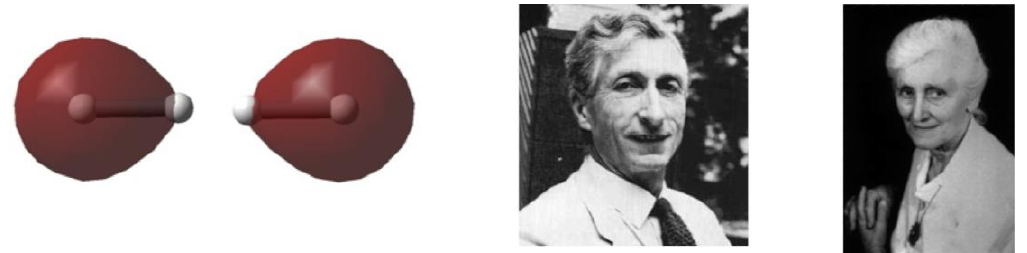
Figure 3. The two Coulson–Fischer AOs, for the H 2 molecule (using STO-3G for simplicity). On the right are photos of Coulson and Fischer. Coulson’s photo was taken from https://iaqms.org/deceased/coulson.php (accessed on 11 March 2021). Fischer’s photo was taken from http://www.quantum-chemistry-history.com/Fi_Hjal1.htm (accessed on 11 March 2021).